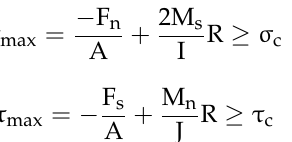
Figure 2. Force–displacement behavior of particle bonding.